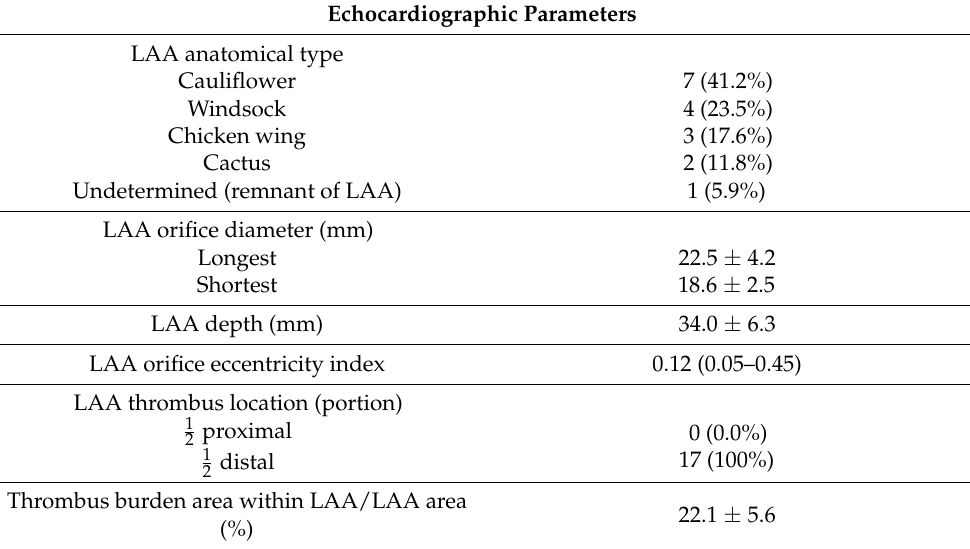
Table 2. Echocardiographic characteristics of study